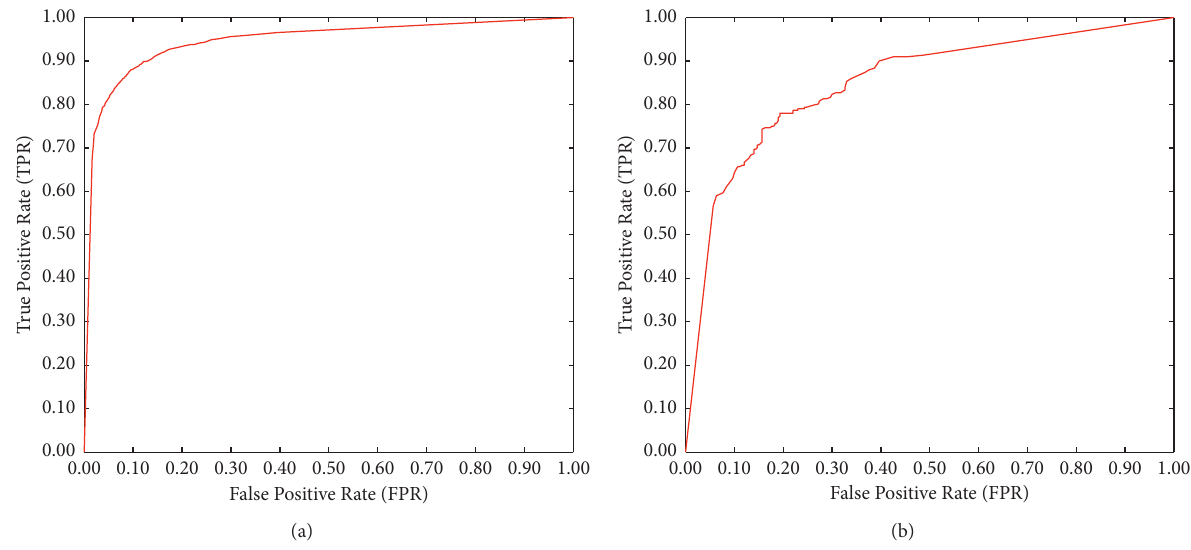
Figure 14: ROCs of CNN-RMSprop: (a) training phase and (b) testing